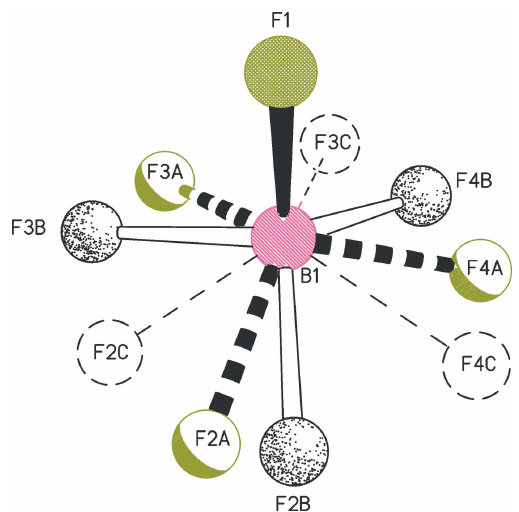
Figure 3 Disorder of the tetrafluoridoborate anion in the structure of 2 . The disorder components A (F2 A , F3 A , F4 A ), B (F2 B , F3 B , F4 B ) and C (F2 C , F3 C , F4 C ) are related by a rotation about the B1—F1